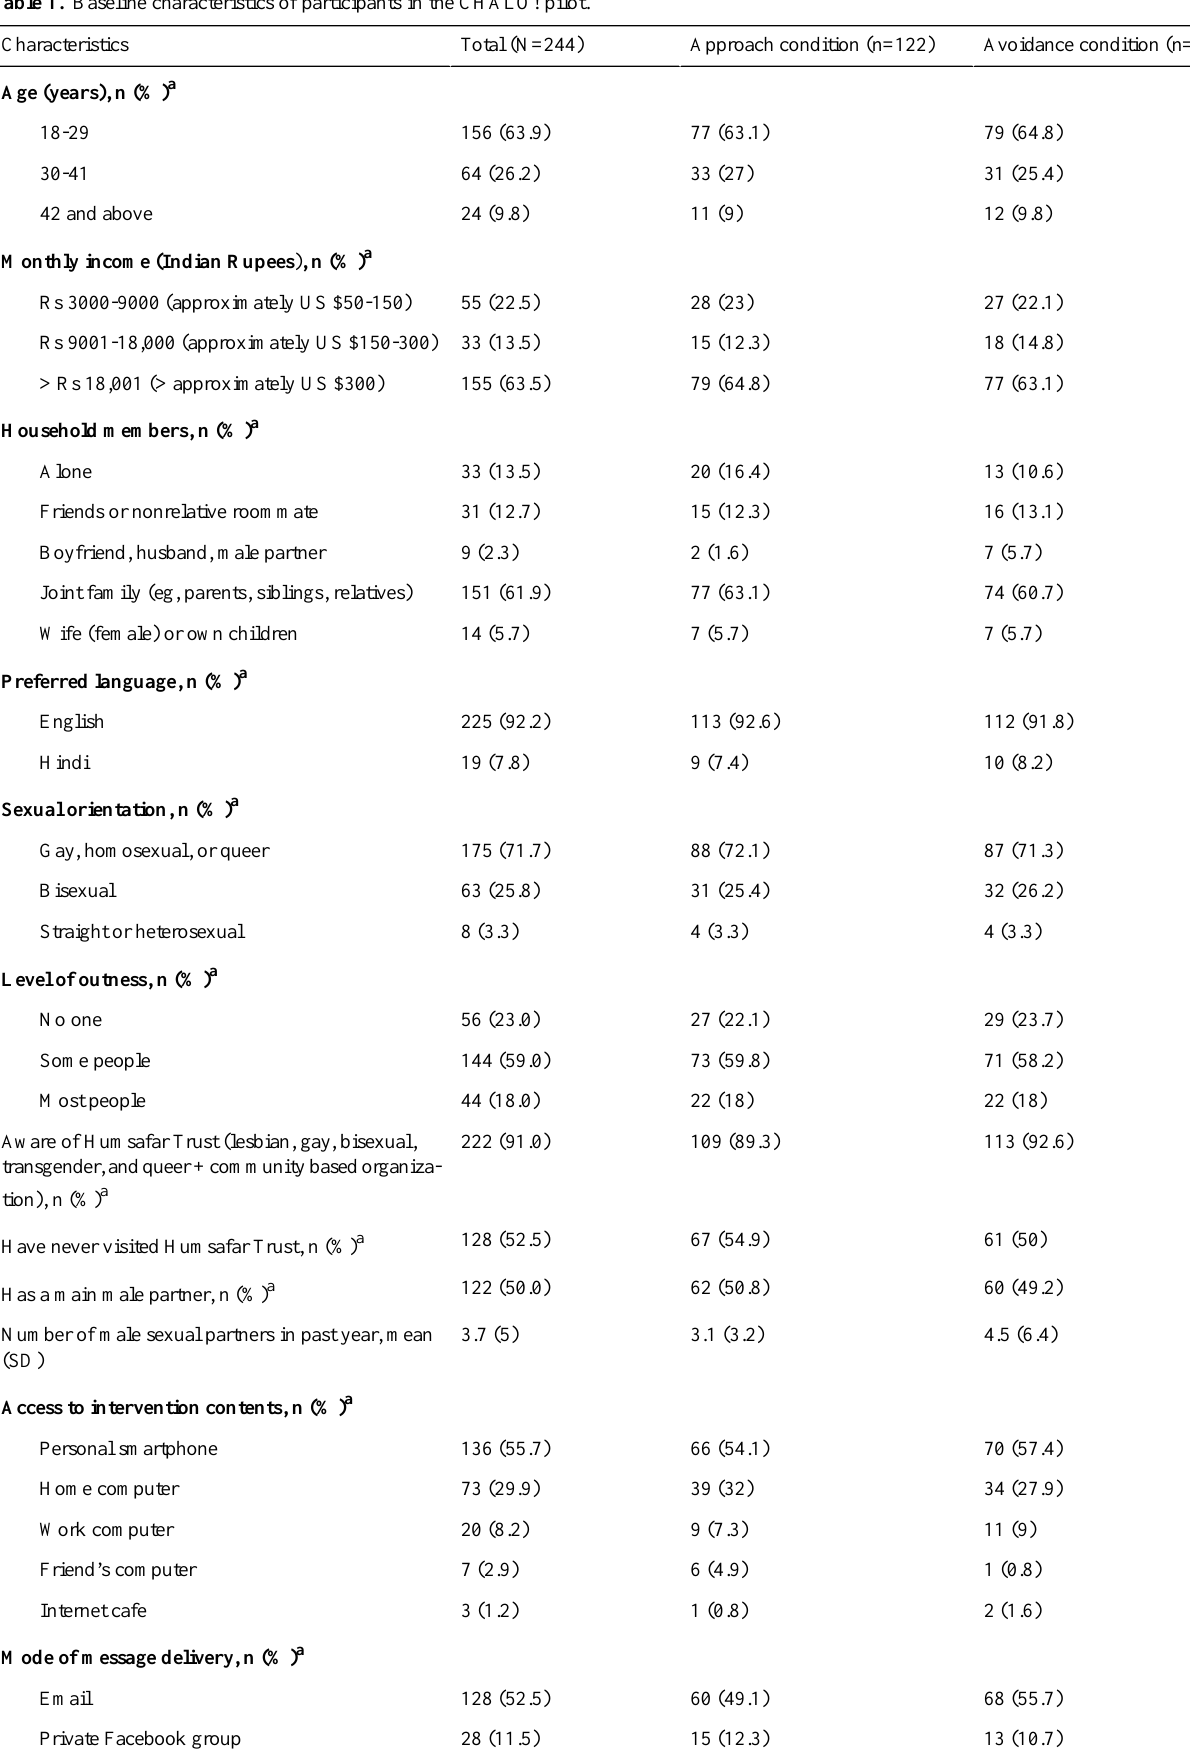
Table 1. Baseline characteristics of participants in the CHALO!